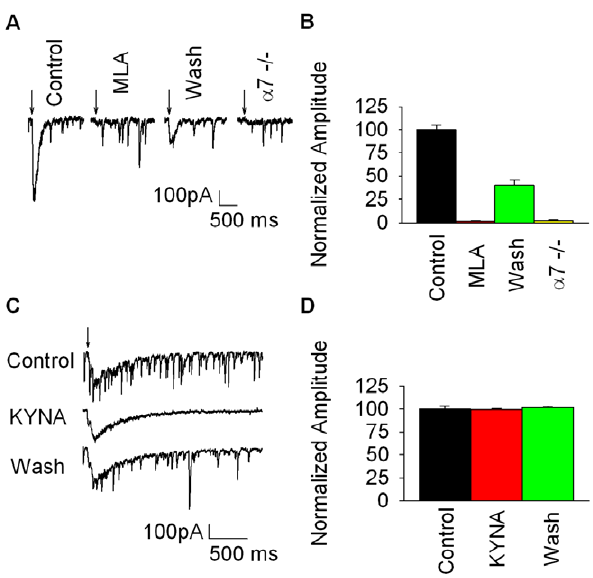
Figure 1. KYNA effects on a 7* currents in mouse hilar interneurons. Panel A shows representative traces for the character- ization of a 7* currents in mouse hilar interneurons. The left most trace shows the control response to pressure applied choline. The next two traces show the response to choline in the presence of MLA (10 nM) and after 30 min washout, respectively. The last trace shows the lack of response to choline in a 7 null mutant mice. Panel B shows the summarized data for these experiments. MLA blocked completely the choline response (t=6.6153, df=7, p=0.0003, n=8, paired t-test, control vs. MLA,), the MLA effect was reversed partially after washout (t=2.6083, df=7, p=0.035, n=8, paired t-test washout vs. MLA; t=4.029, df=7, p=0.005, n=8, paired t-test washout vs. control,), and